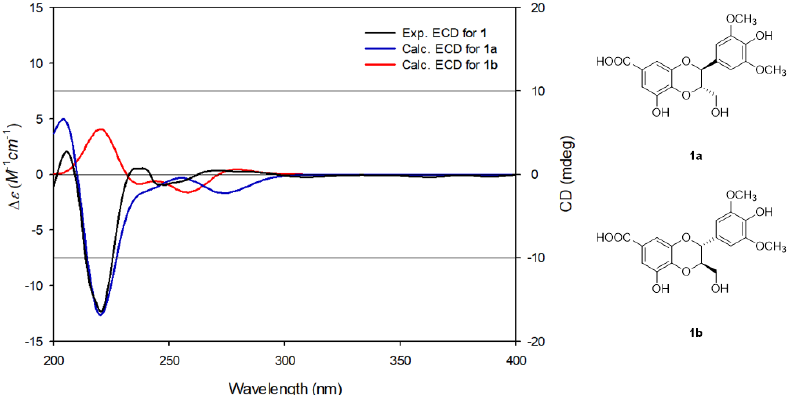
Figure 3. Experimental and calculated ECD (electronic circular dichroism) spectra of compounds 1 , 1a , and 1b . 1a , and 1b